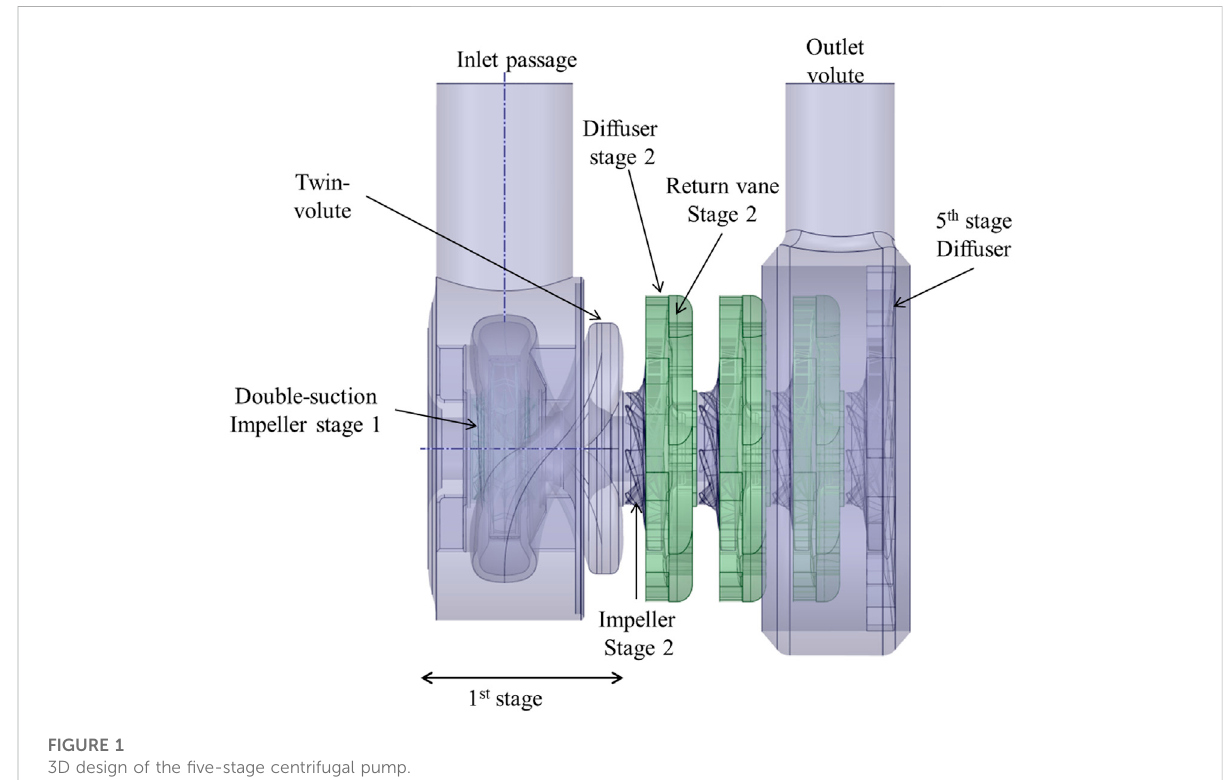
FIGURE 1 3D design of the fi ve-stage centrifugal pump.